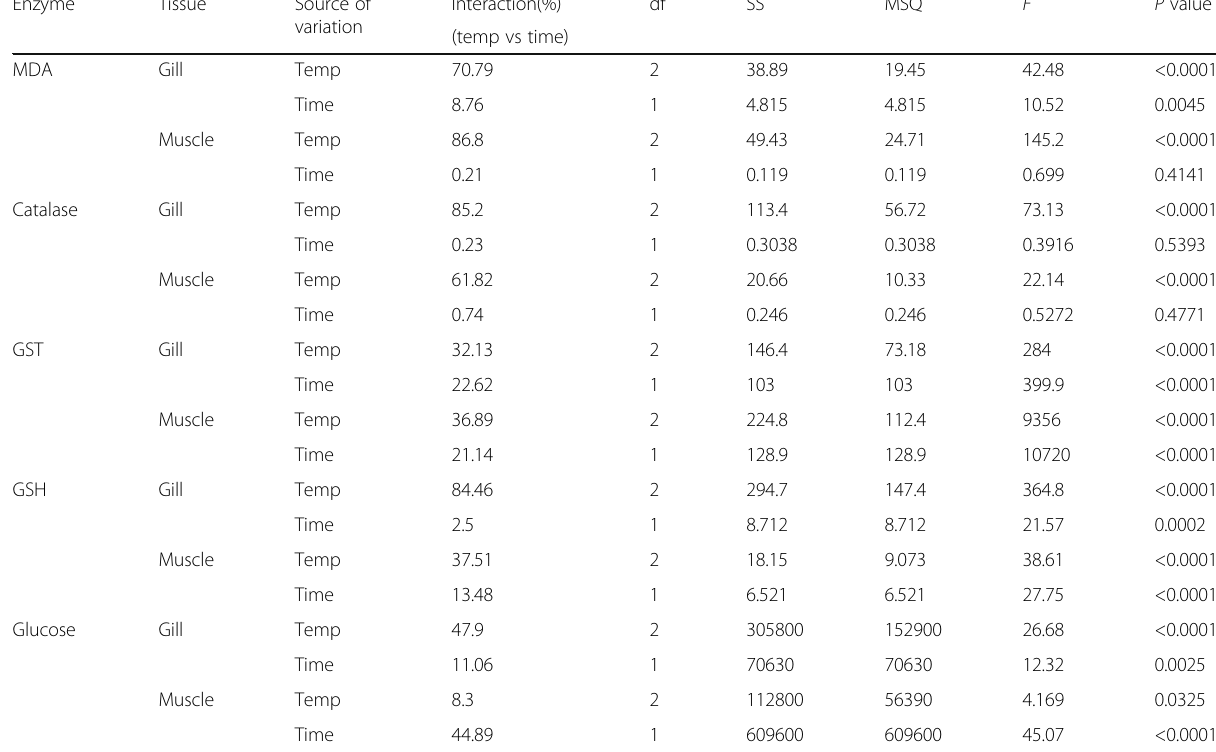
Table 1 Significance levels of the two-way ANOVA testing effects of temperature (temp: 15 °C, 25 °C and 35 °C) and time (time: 3 and 6 h) on organs (gills and muscles) of Cyprinus carpio var koi for MDA, catalase, GST, GSH and glucose Enzyme